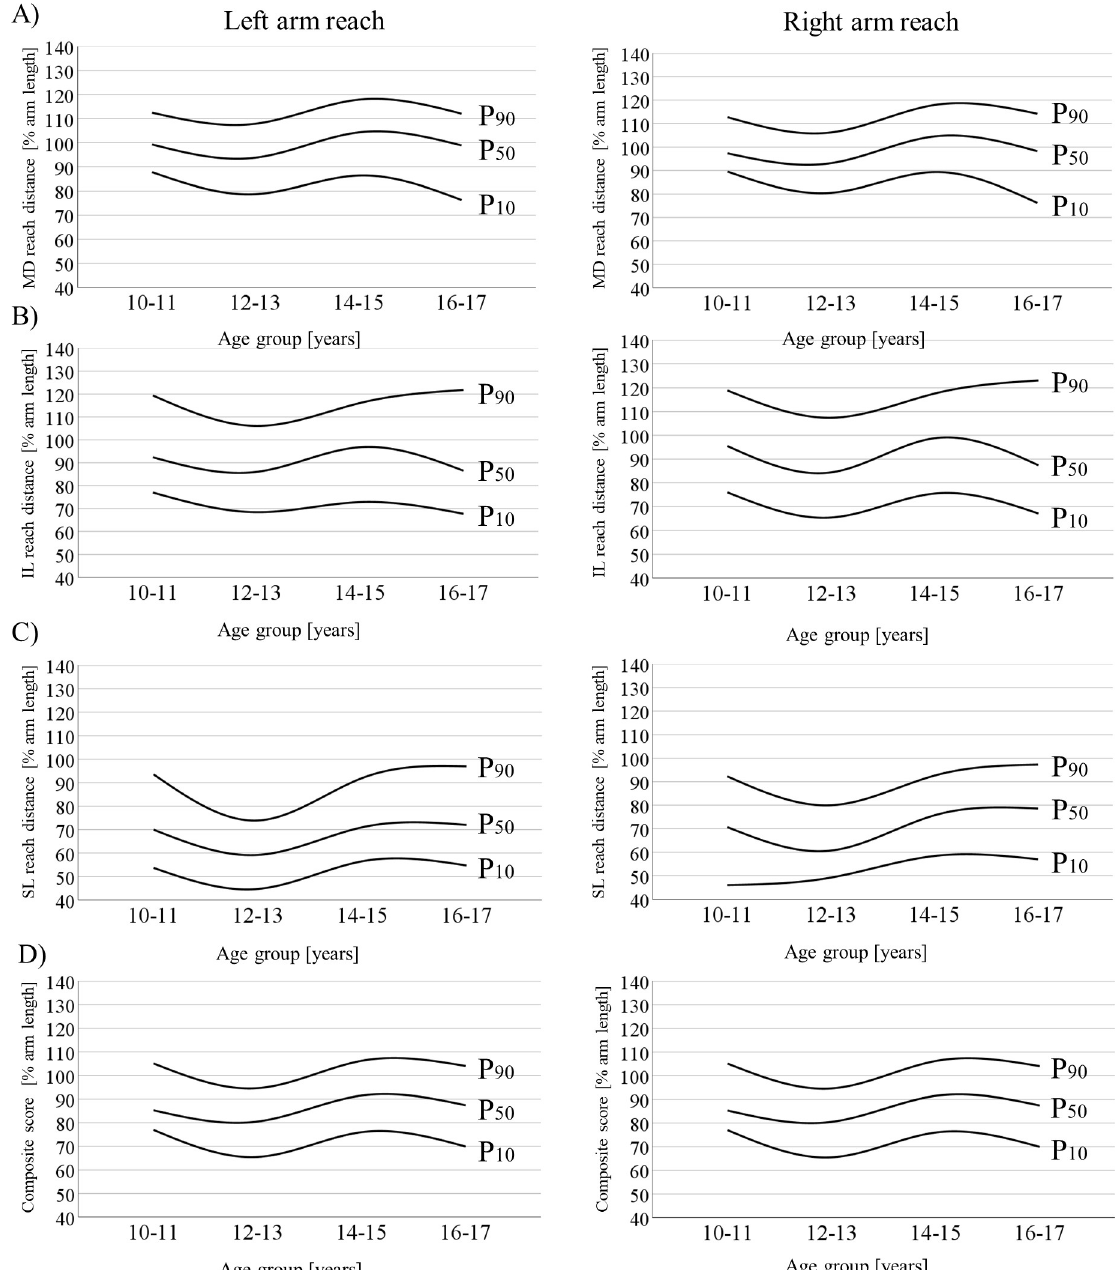
Fig 2. Smoothed curves for the 10 th , 50 th , and 90 th percentiles (% arm length) of the (A) medial, (B) inferolateral, and (C) superolateral reach directions as well as the (D) composite score during left and right arm reach in males aged 10 to 17 years. IL = inferolateral; MD = medial; SL =